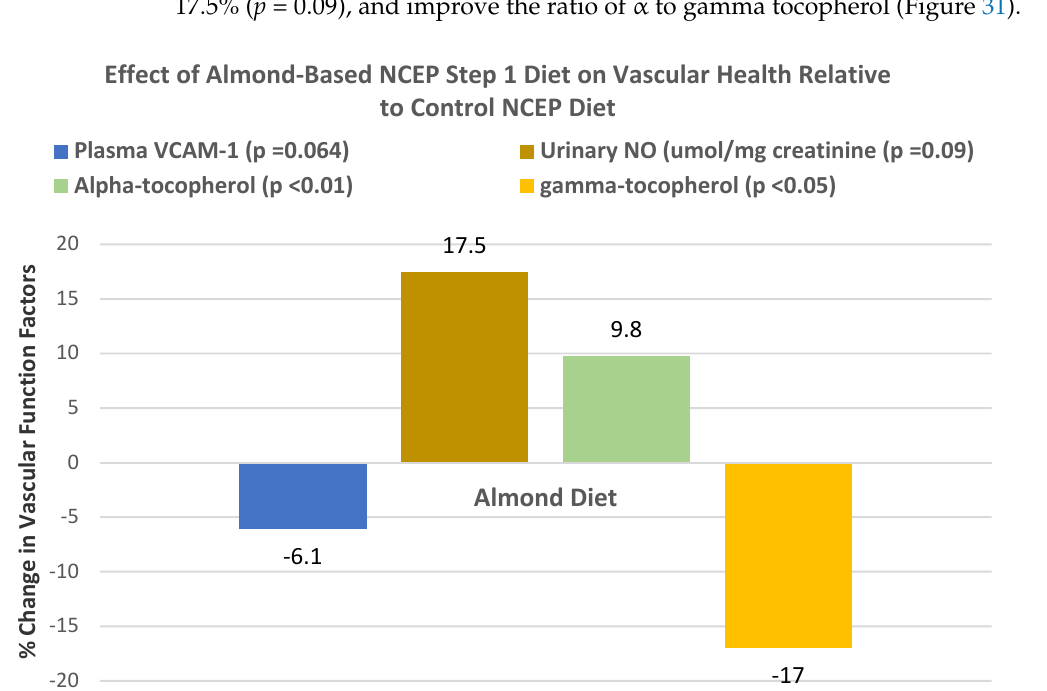
Figure 31. Effect of almond National Cholesterol Education Program (NCEP) Step 1 diets on vascular function factors and tocopherols relative to control NCEP Step 1 diet from baseline to 6 weeks [86].